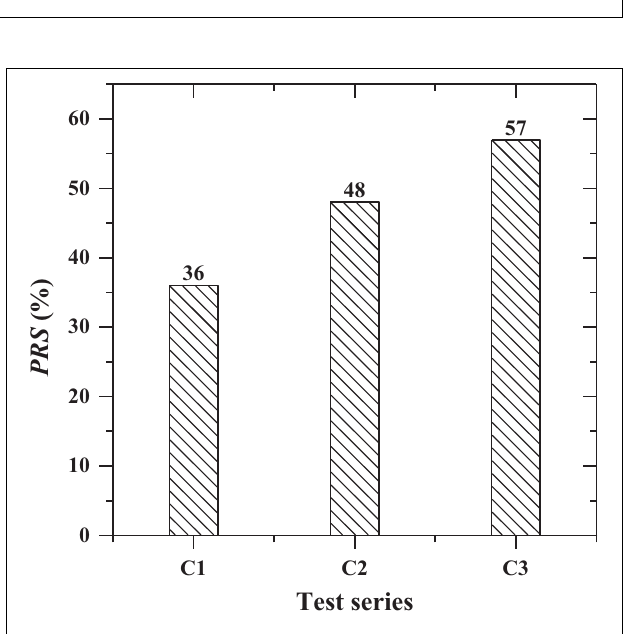
FIGURE 3 | Detailed sectional view of reinforced test bed.